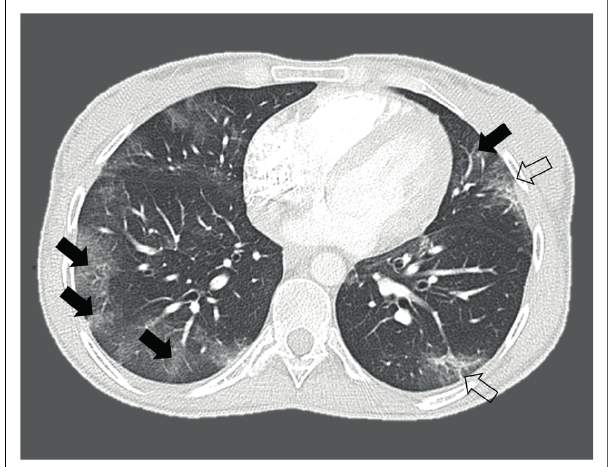
FIGURE 6: Axial CT lung window of a 31-year-old female patient with no comorbidities, who presented with dyspnoea, fever and a sore throat. Typical findings of peripheral patchy ground glass opacities in the lower lobes (black arrows) with interlobular septal thickening (open